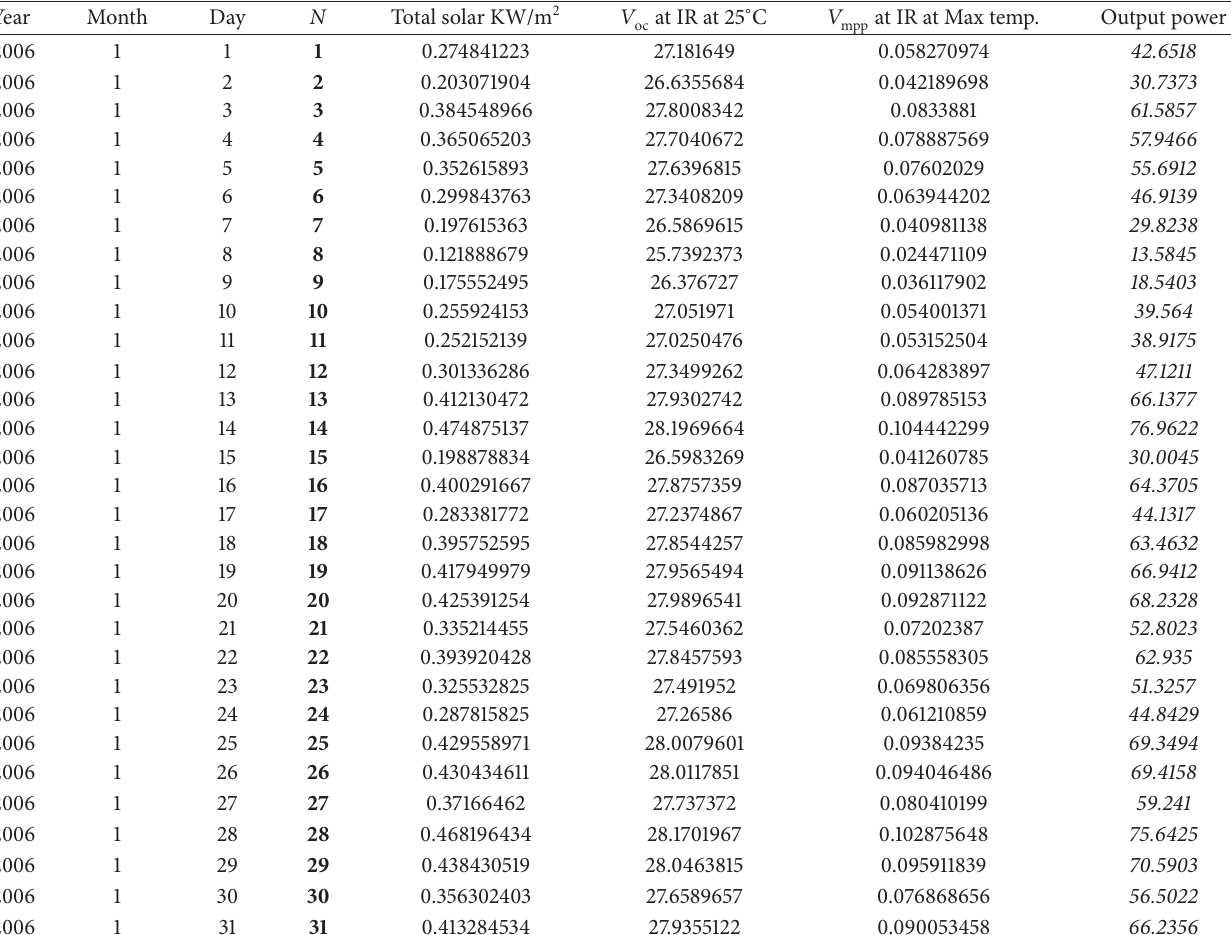
Table 4: Sample data for modelling of